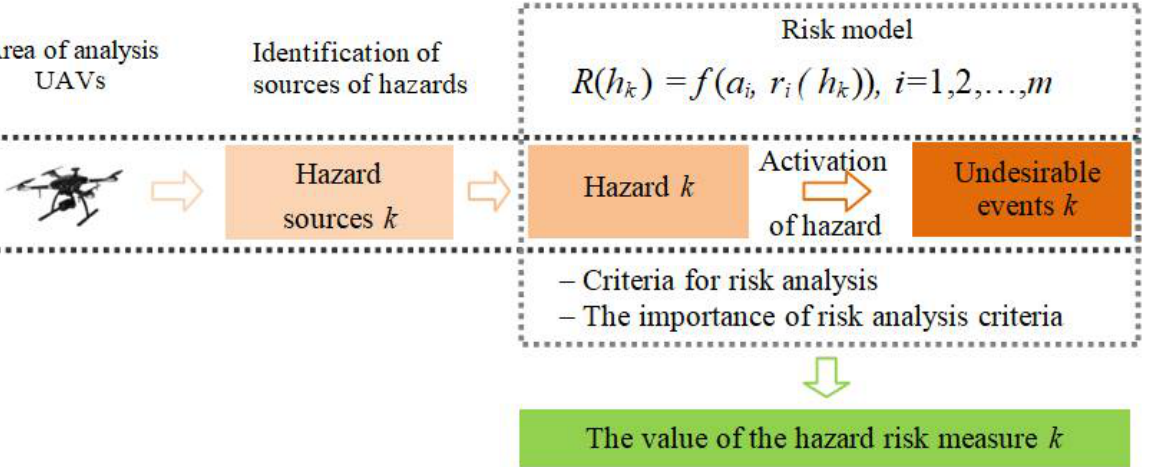
Figure 2. Place of the model and risk measures on the basis of [20].